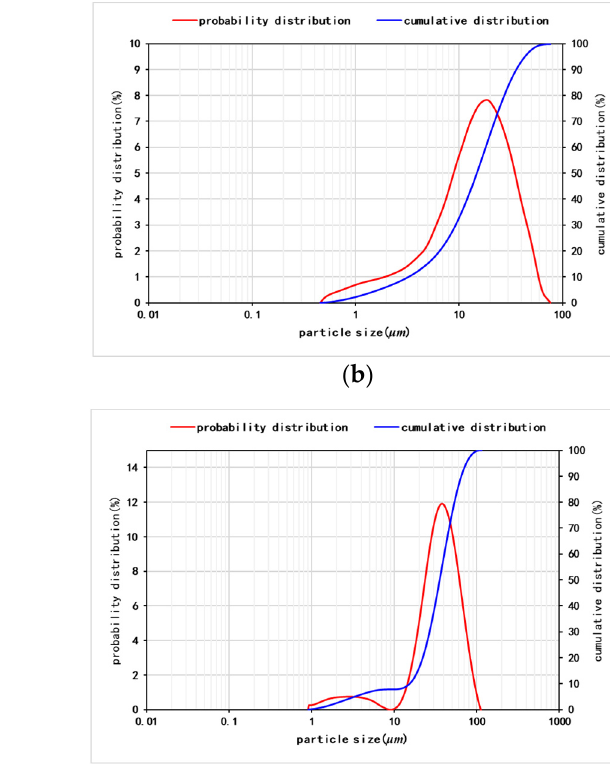
Figure 3. The particle size test results of nano-microspheres under different standing times. ( a ) The newly prepared dispersion on ( b ) day 1, ( c ) day 2, and ( d ) day 3.